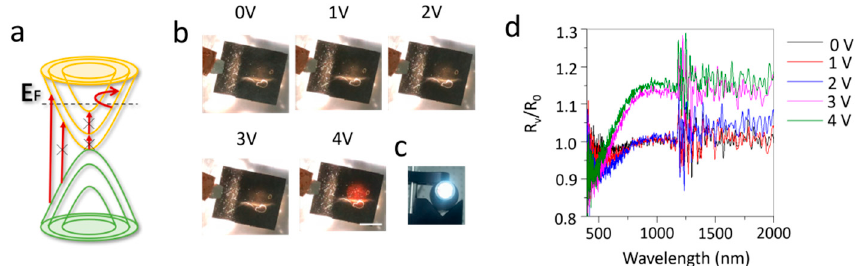
Figure 3. The in-situ reflection of ionic liquid intercalated multilayer graphene device. ( a ) Electronic band structure of doped multilayer graphene and possible electronic transitions. × means that this transition is blocked due to the upshift of Fermi level. ( b ) Photographs of the devices under di ff erent voltage bias, with a xenon lamp ( c ) under the device. The scale bar in ( b ) is 1 cm. ( d ) Reflectance spectra (R V / R 0 ) of the multilayer graphene device on polished copper plate under di ff erent voltage bias.